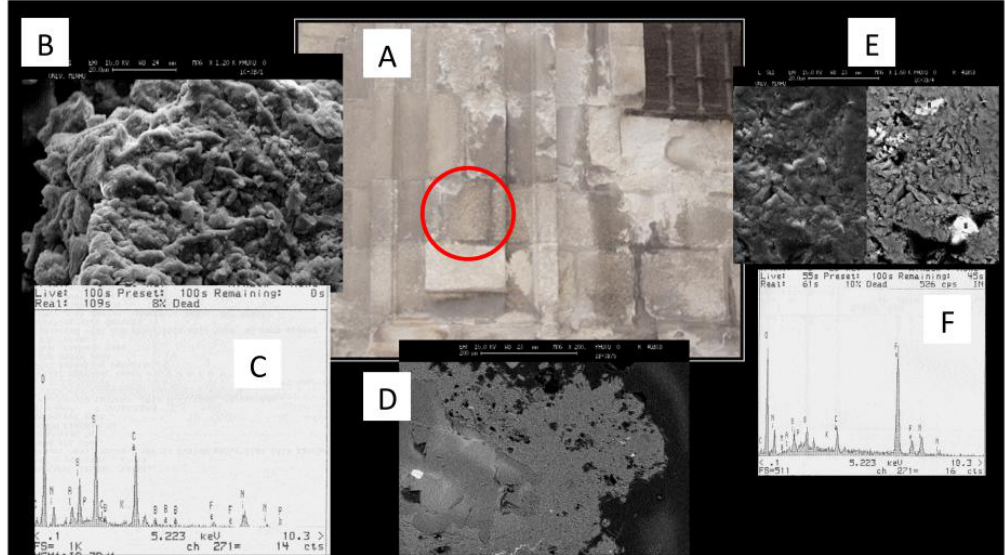
Figure 4. Covering layer on a wall of the Church of the Capuchinas (A Coruña). ( A ) Area of the wall where the covering layer was taken, ( B ) surface SEM picture, ( C ) EDS of the surface, ( D ) SEM picture of a cross-section of the covering layer, ( E ) Fe-rich particle, and ( F ) EDS of the particle.